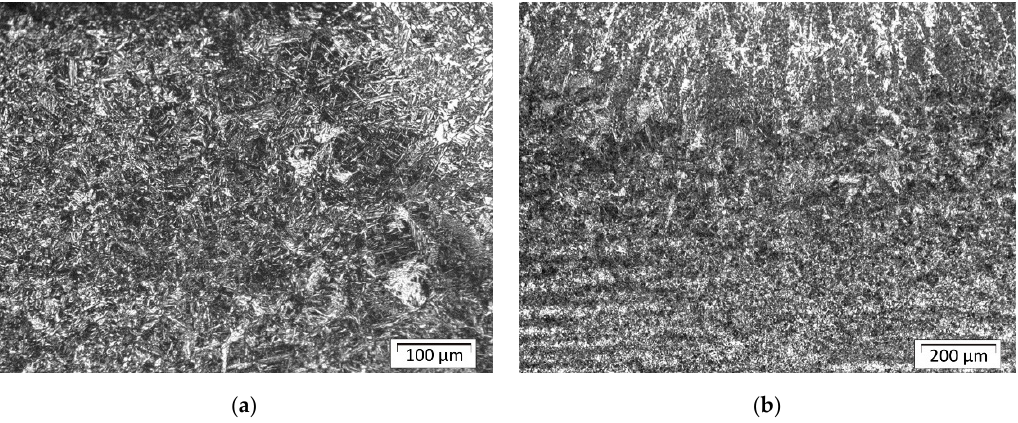
Figure 12. Sample A: ( a ) HAZ in front of bead number one; ( b ) fusion line and HAZ in axis of bead number one.